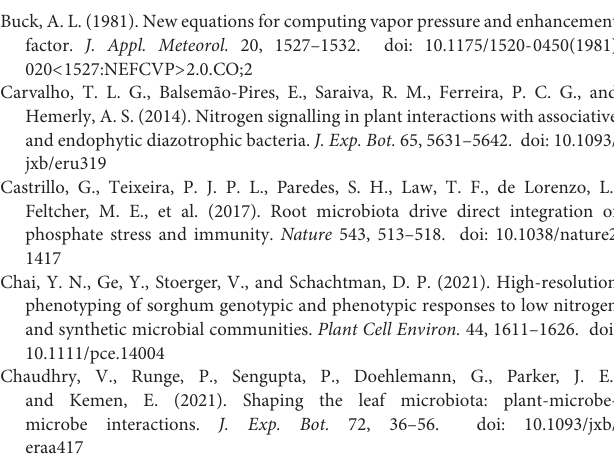
Supplementary Figure 2 | Sensors and materials used for the non-invasive real-time phenotyping platform. Supplementary Figure 3 | Differential phenotypic responses of three commercial hybrids of maize (DKB177, SX7341, and P3707VYH) to the presence of SynCom under DS. Supplementary Figure 4 | SynCom inoculation differentially affects seedling emergence timing and reproductive stages of maize. Supplementary Figure 5 | SynCom differentially impacts yield-related parameters and plant biomass of commercial hybrids of maize under DS conditions. Supplementary Figure 6 | Maize canopy structure throughout a day as a function of air temperature detected by the non-invasive real-time phenotyping platform. Supplementary Figure 7 | Continuous plant monitoring revealed a direct influence of natural environmental variables in canopy aspect. Supplementary Figure 8 | SynCom differentially affects maize hybrids by dramatically changing T leaf control under WW conditions. Supplementary Figure 9 | SynCom delays the T leaf increase in SX7341 maize plants under WW conditions. Supplementary Figure 10 | SynCom induces an increase in the T leaf of maize plants under DS conditions. Supplementary Figure 11 | Enriched and depleted resident microbial groups in inoculated plants. Supplementary Table 1 | Three-way ANOVA for phenotypic parameters (yield per plant, kernels per plant, kernel rows per ear, ear diameter, ear length, and aerial biomass) of genotype, irrigation regime, inoculation and all their possible interactions. Supplementary Table 2 | Harvest index (HI) for inoculated and uninoculated DKB177, SX7341, and P3707VYH under WW and DS conditions. Supplementary Table 3 | Relative abundance of community-based isolates considered robust colonizers in WW- and DS-treated inoculated DKB177, SX7341, and P3707VYH hybrids. Supplementary Movie 1 | Time-lapse movie of late stages of severe drought and rehydration of DKB177, SX7341, and P3707VYH maize hybrids inoculated or uninoculated with SynCom. Supplementary Dataset 1 | Physiological data collected by the plant phenotyping platform. Supplementary Dataset 2 | Environmental data collected by the plant phenotyping